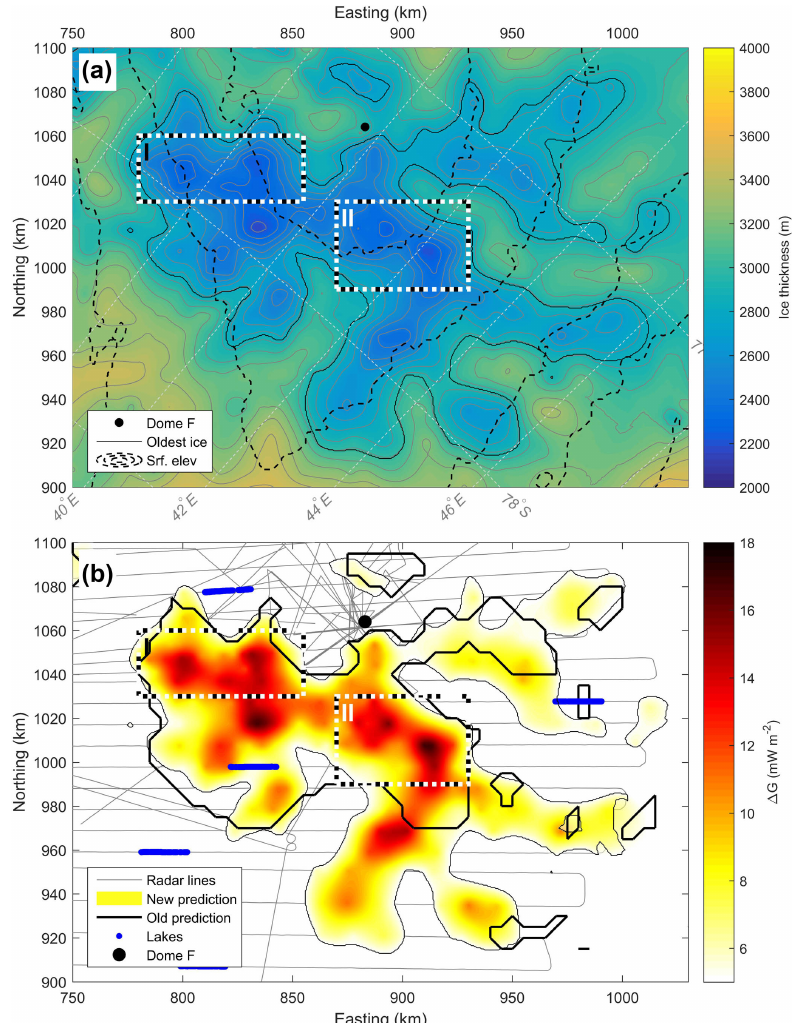
Figure 7. (a) Ice thickness in the area close to Dome Fuji station in 500m resolution and (b) updated predictions of possible Oldest Ice locations (colours) on a 500m resolution grid compared to the prediction of Van Liefferinge and Pattyn (2013) outlined in black. The colour scale show the values of (cid:49)G , semi-transparent colours show areas with a threshold horizontal ice-flow velocity of < 2ma − 1 , fully saturated colours show areas where the threshold is < 1ma − 1 . Blue dots show lake locations identified from the radar data. The white and black boxes indicate the two most favourable Oldest Ice spots according to our